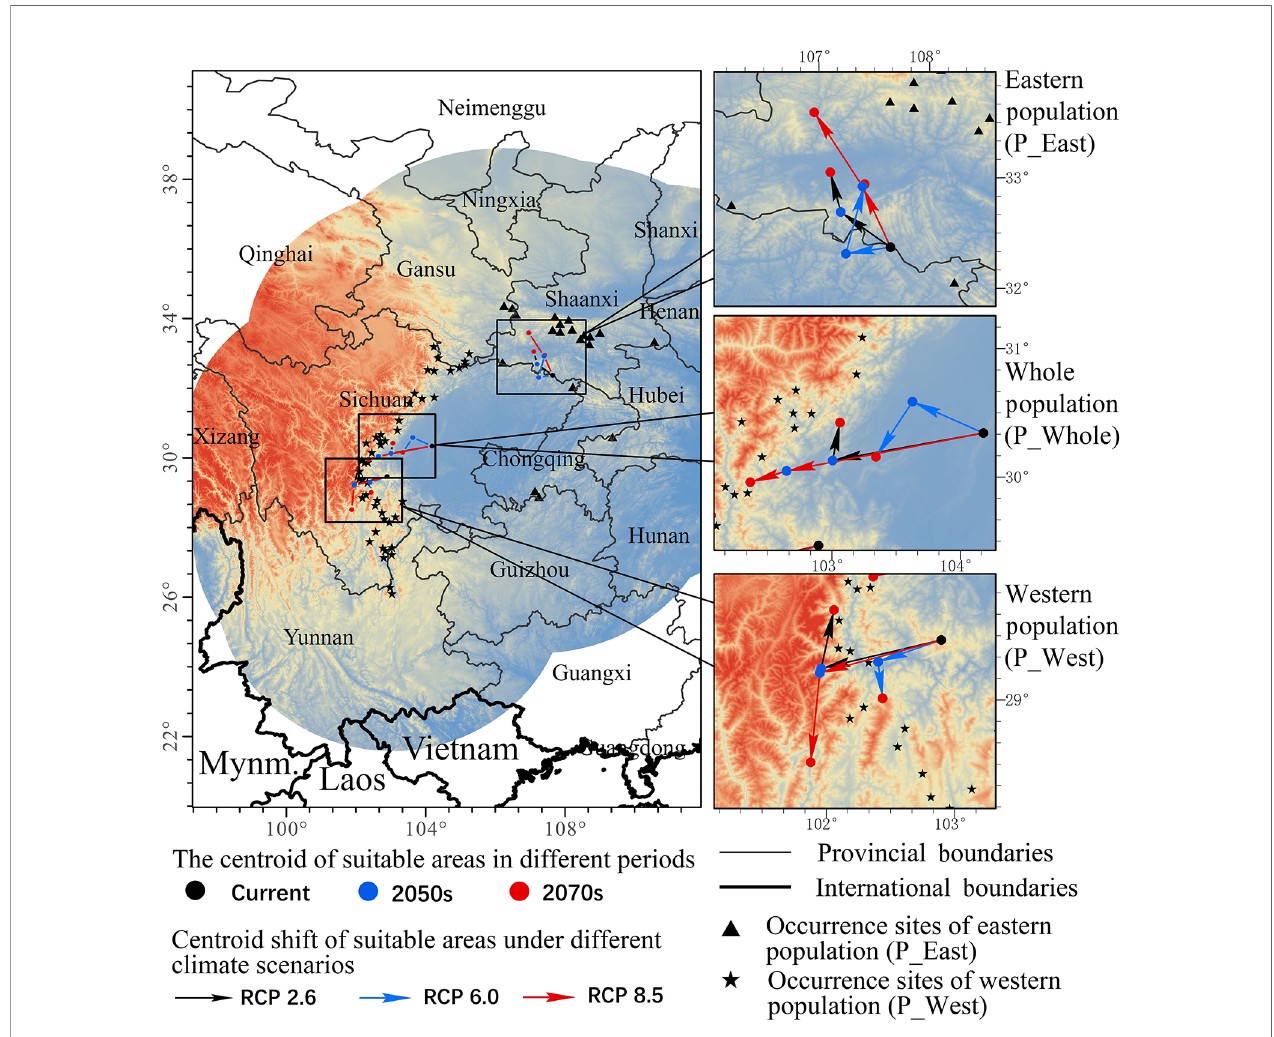
FIGURE 5 | Core distributions of different species distribution models (constructed with eastern population (P_East), western population (P_West), and whole population (P_Whole) of P. mairei ) and their changes under climate change, including two periods (from now until the 2050s and from the 2050s – 2070s) under three climate scenarios (RCP2.6, RCP6.0, and RCP8.5). P_East shows a north shift trend while P_West and P_Whole may shift west, although the overall trend of all populations was